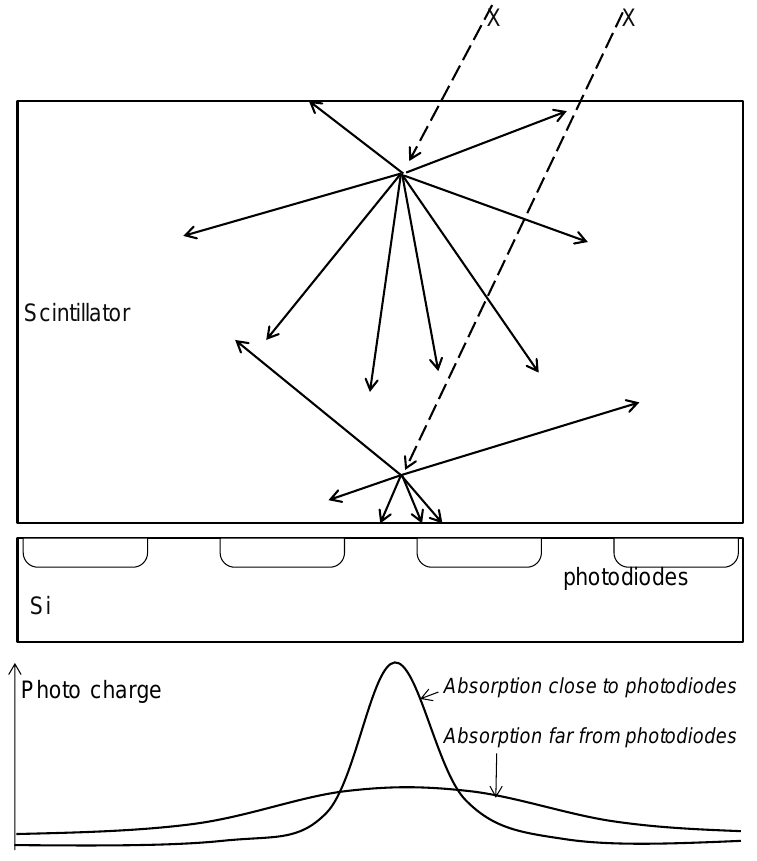
Figure 14. Schematic drawing of Lubbert’s effect in a scintillator-covered Si pixel array. Shallow absorption (far from the silicon photodiodes) versus deep absorption (close to the silicon photodiodes) results in larger or lesser optical diffusion of photo charges to neighboring pixels. As a consequence, one will see